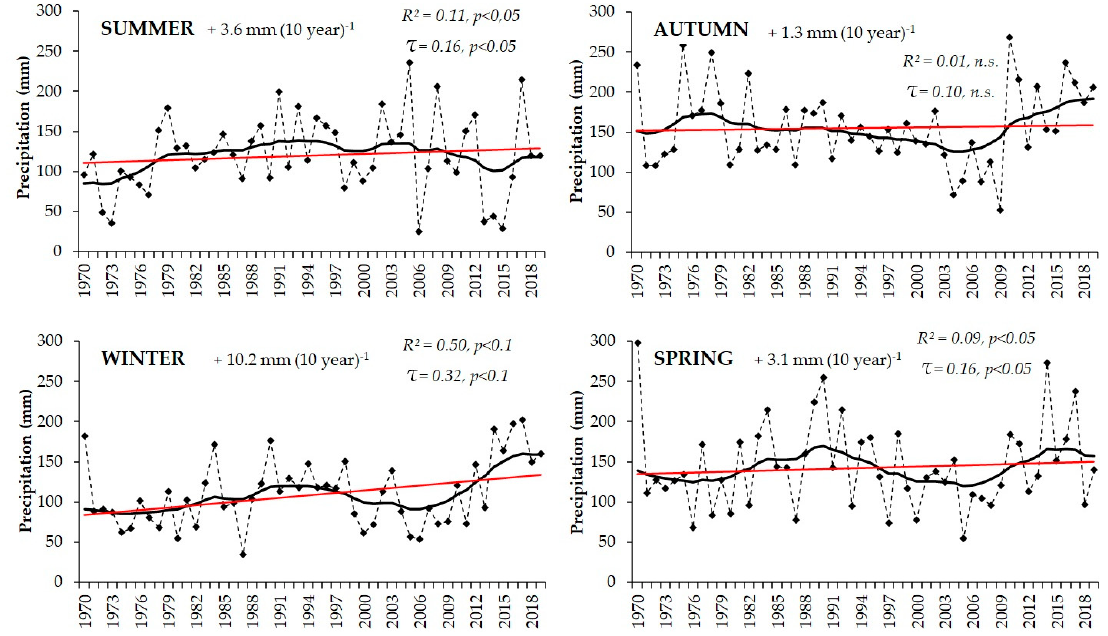
Figure 3. Seasonal behavior of the areal average precipitation from Frei, Prat, and O’Higgins stations. τ is the Kendall´s tau rank correlation applied to the linear trends (Equation (11)).